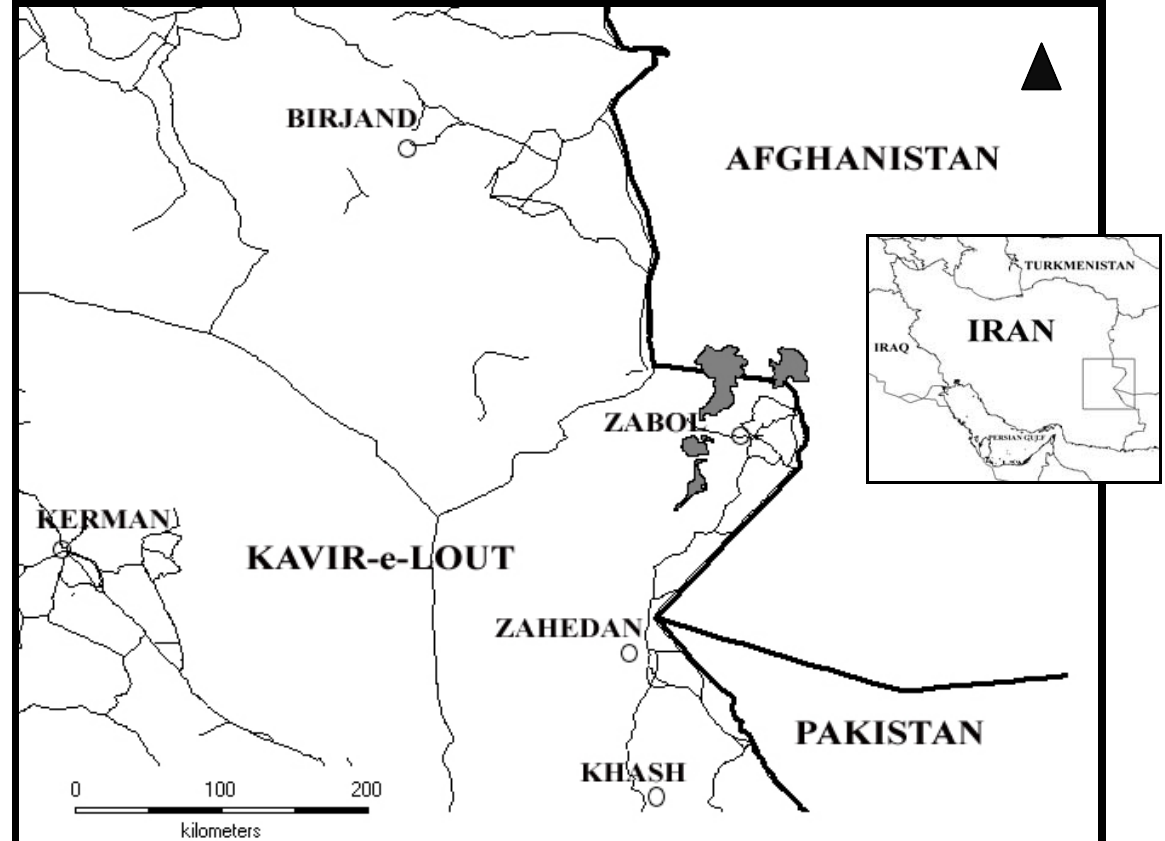
F IG .1. - Collection localities at northeast and eastern parts of